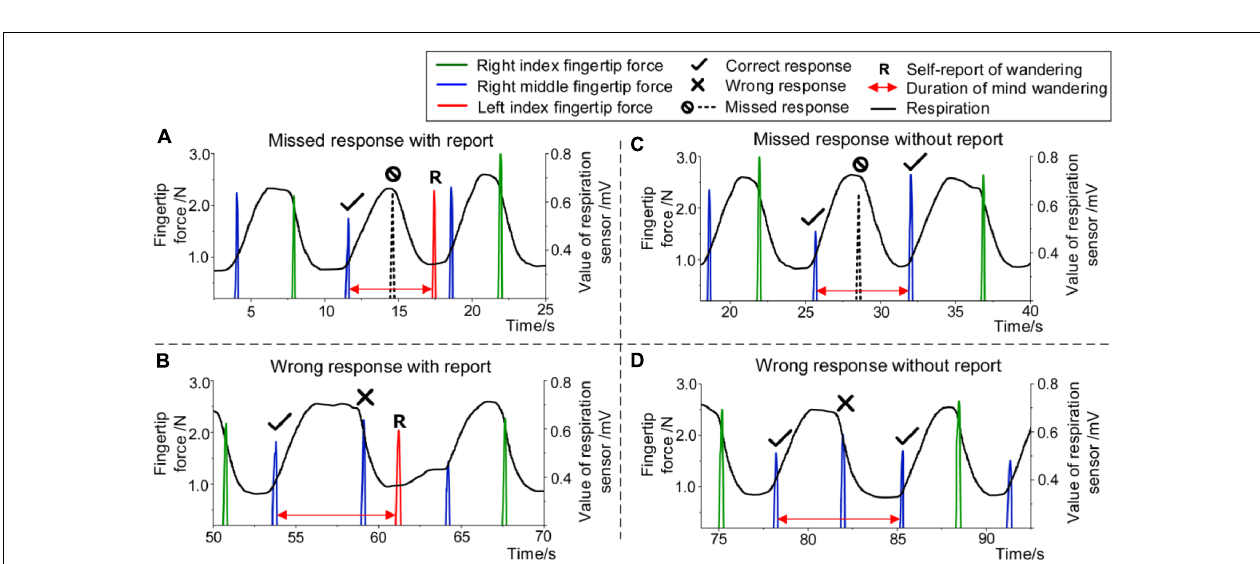
FIGURE 3 | Estimating duration of mind wandering. For (A) missed response with self-report and (B) wrong response with self-report, the duration was considered from the end of the latest correct trial to the self-report. For (C) missed response without self-report and (D) wrong response without self-report, the duration was considered from the end of the latest correct trial to the beginning of the next correct